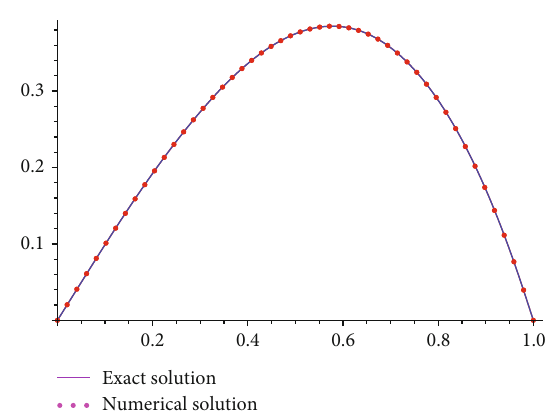
Figure 10: Relative errors of u method for Example 1